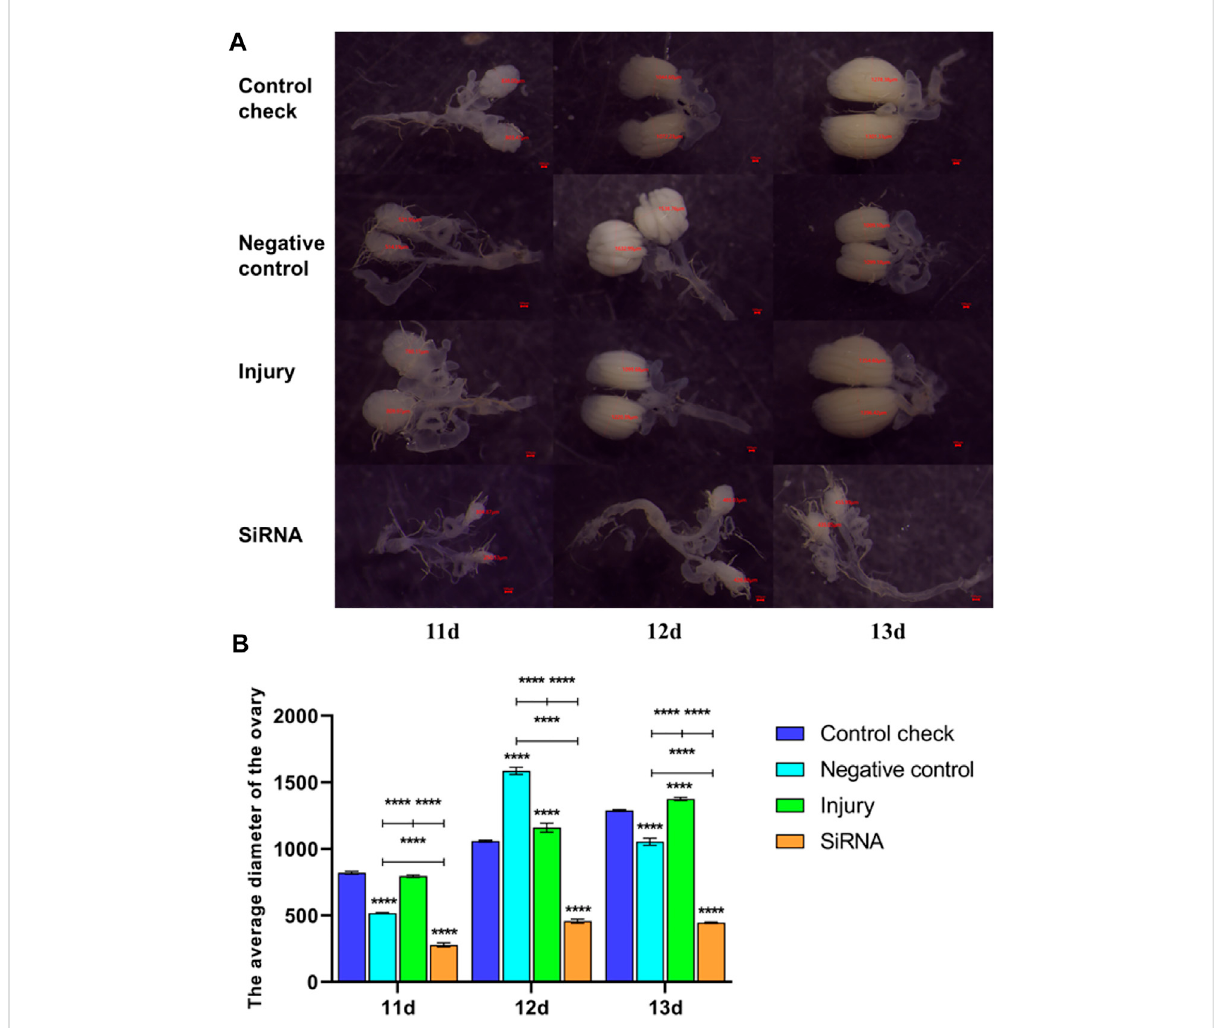
FIGURE 9 Effects of interfering target genes on ovarian development of Z. cucurbitae (Coquillett) after the 45 ° C treatment for 1 h. (A) Rate of ovarian development. The red line denotes the diameter of the ovary ( μ m). (B) Average diameter of the ovary ( F (3, 24) = 1,158, p < 0.0001; F (2, 24) = 901.2, p < 0.0001; F (6, 24) = 183.0, p < 0.0001). All values in the fi gure are presented as mean ± standard error. *, **, ***, and **** above the histograms indicate the values that differ signi fi cantly between treatments p ≤ 0.05, p ≤ 0.01, p ≤ 0.001, and p ≤ 0.0001,